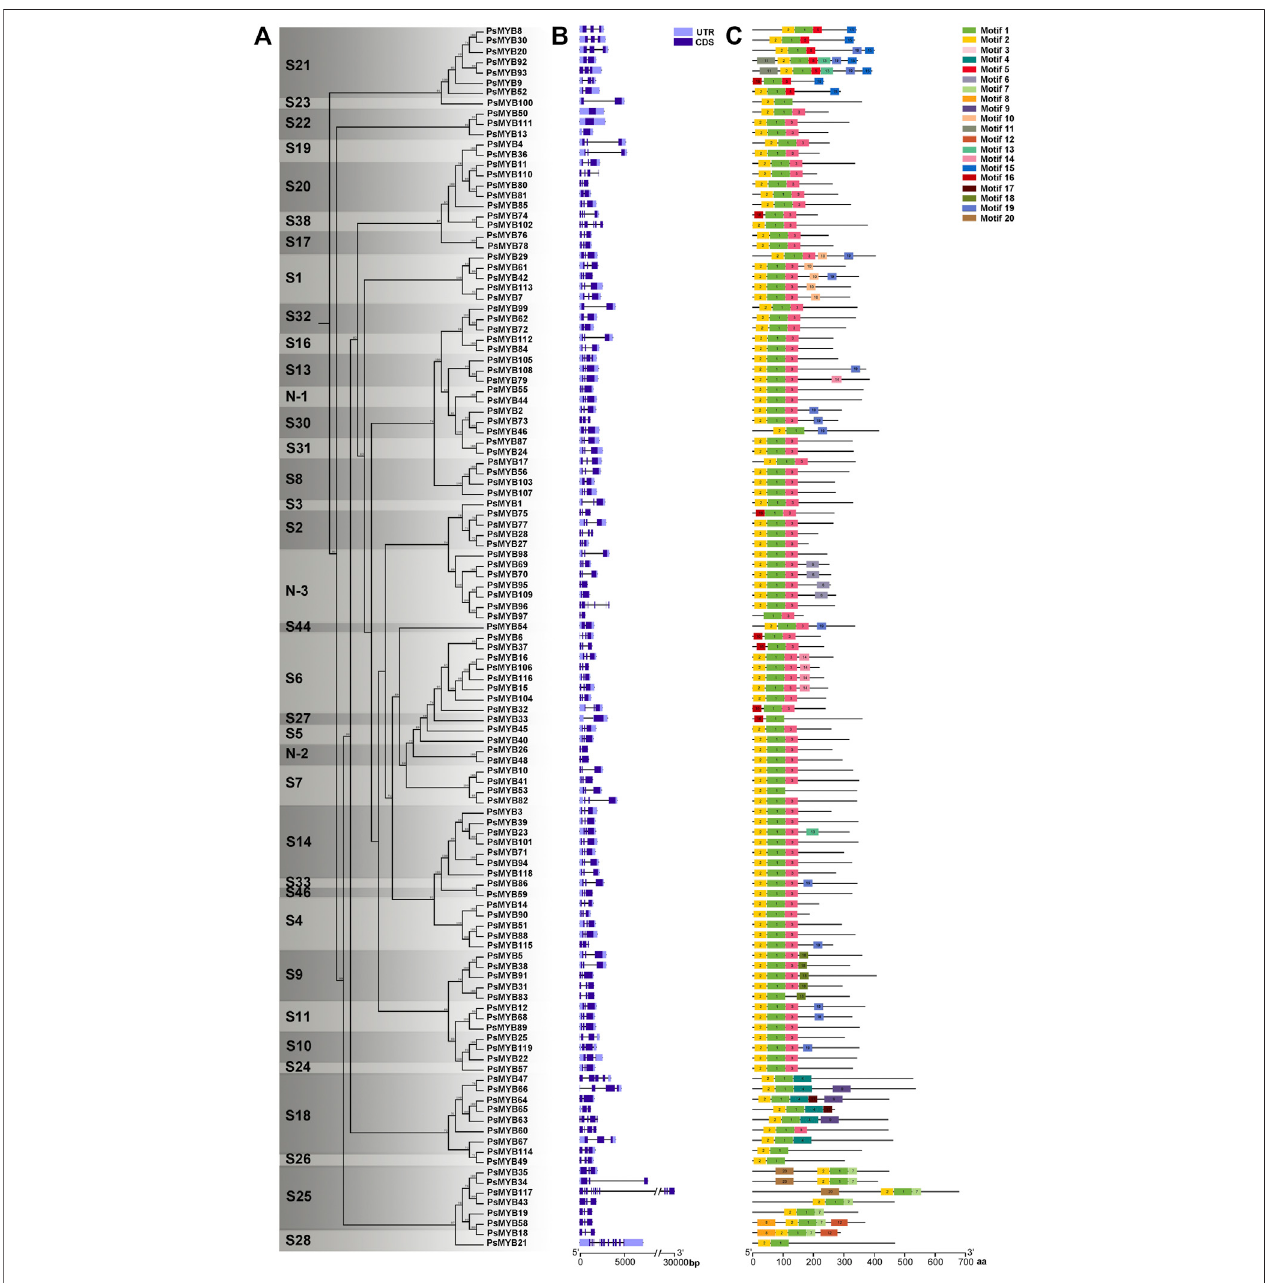
FIGURE 3 | Phylogenetic, gene structure, and Motif analyses of R2R3-MYB genes of pea. (A) Phylogenetic relationships between R2R3-PsMYBs. The phylogenetic tree (left panel) was constructed with MEGA 6.0 using the Neighbor – Joining (NJ) method with 1,000 bootstrap replicates. (B) Gene structure analysis of R2R3-MYB genes. Gene structure maps were drawn with the TBtools. The green box, orange box, black lines indicate coding sequence (CDS), the untranslated region (UTR), and the intron, respectively. The scale bar is shown at the bottom. (C) Motif analysis of R2R3-MYB genes. Twenty conserved Motifs are shown in different colors, the Motif sequence information is provided in Supplementary Figure S1 . All Motifs were identi fi ed by MEME Version5.1.1 software.